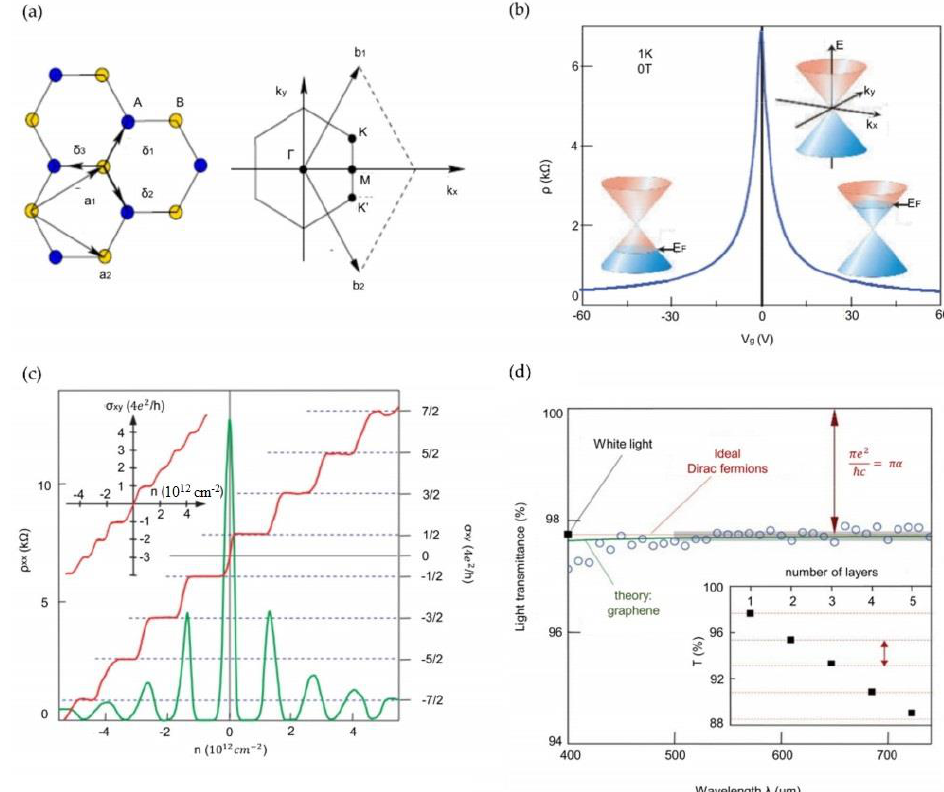
Figure 1. Electronic and optical properties of graphene. ( a ) Hexagonal lattice structure ( left ) and its Brillouin zone ( right ). ( b ) Ambipolar electric effect of single-layer graphene. ( c ) Response of graphene in terms of hall conductivity (red) and longitudinal resistivity (green) with respect to the carrier concentration. ( d ) Transmittance spectrum of single-layered graphene. Reproduced from